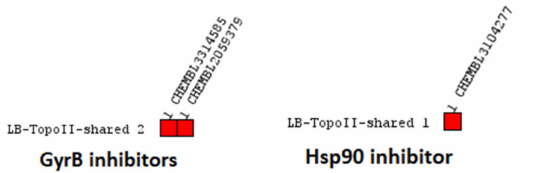
Figure 14. Heatmaps obtained after screening 221 of the most potent GyrB inhibitors (IC 50 < 100 nM) and 649 Hsp90 inhibitors (K d < 100 nM) using TopoII 3D-pharmacophore models. LB-TopoII-Model-5 , a shared feature (consensus) model retrieved both GyrB and Hsp90